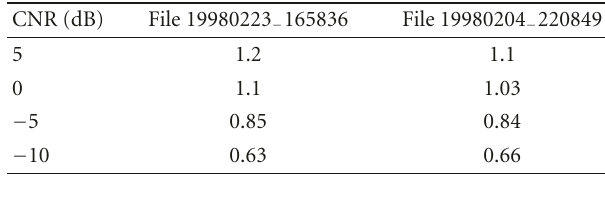
versus CNR (dB) for N = 8, K = 24, 0